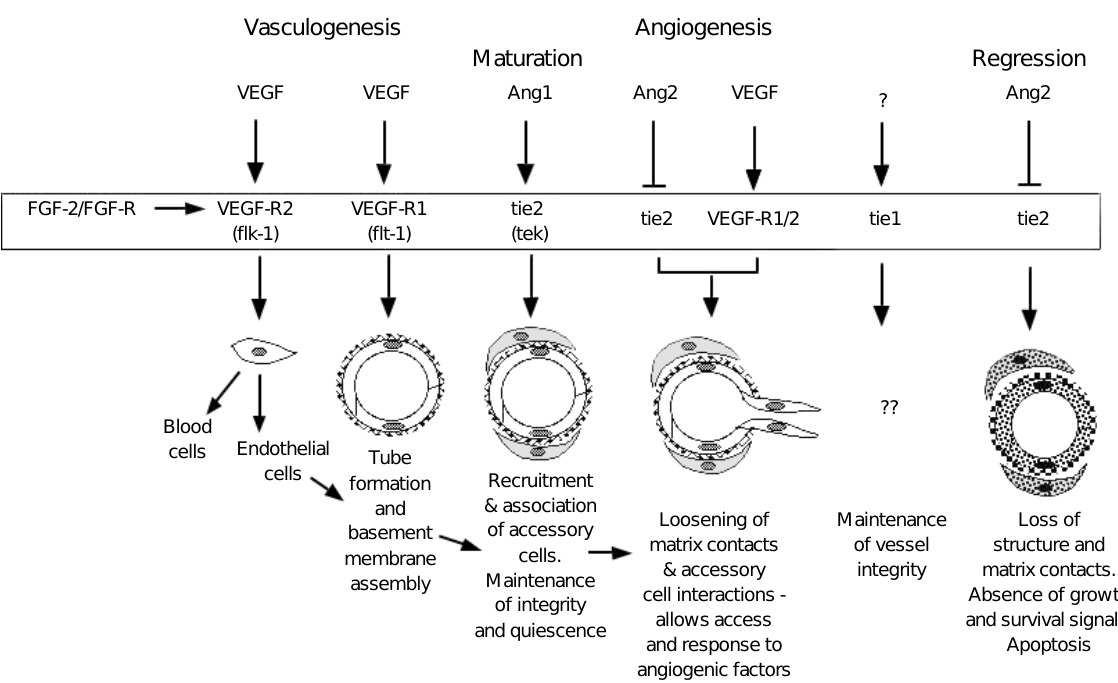
Figure 1 - Regulation of vessel formation. Diagram depicts the various phases of vascular development, the multiple growth factors impinging on endothelial cells (basic fibroblast growth factor (FGF-2), vascular endothelial growth factor (VEGF), angiopoietins) and their receptors. Factors and ligands are arranged according to the processes they affect, based on inferences drawn from the phenotypes of genetically modified mice. Thus, VEGF acting through VEGF-R2 (flk-1) affects the “birth” of endothelial cells, whereas VEGF acting through VEGF-R1 (flt-1) instead affects tube formation and VEGF collaborating with angiopoietins affects recruitment of accessory cells and angiogenesis. What is unclear, and is not shown here, is how these ligand-receptor combinations affect the morphogenetic events involving cell-matrix and cell-cell adhesion. It is in this part of these processes that integrins and their ligands may play a role (see text). Modified from an original diagram by Hanahan (14).